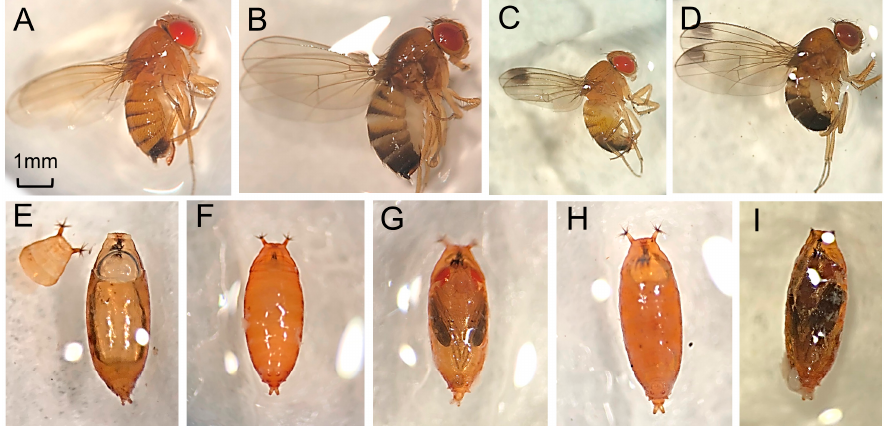
Figure 2. Differences in D. suzukii phenotypic expression of size and pigmentation when reared at warm ( A , C ) and cool ( B , D ) temperatures. Adult SM female ( A ), adult WM female ( B ), adult SM male ( C ), and adult WM male ( D ). Cast pupal case from a recently eclosed D. suzukii ( E ), healthy undeveloped pupa 2 days post-pupation ( F ), healthy developed pupa 5 days post-pupation ( G ), dead undeveloped pupa ( H ), dead developed pupa ( I ).